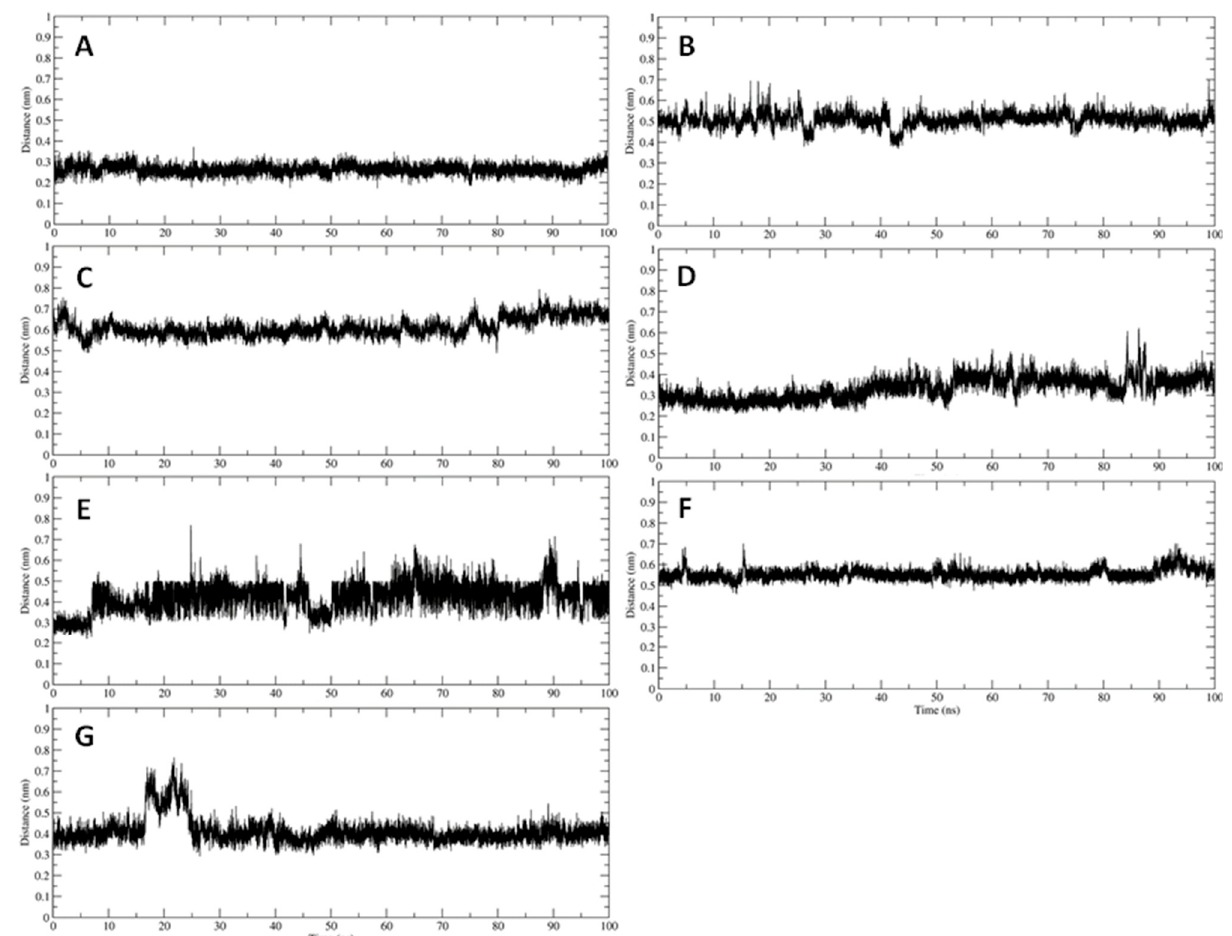
Figure 4. Distance as a function of simulation time between the active site of the protease and the compounds identified through docking experiments. ( A ) Complex between the protease and vitexin. ( B ) Complex between the protease and pentagalloyl-glucose. ( C ) Complex between protease and quercetin. ( D ) Complex between protease and magniolioside. ( E ) Complex between protease and isovitexin. ( F ) Complex between the protease and artelin. ( G ) Complex between the protease and isoorientine. Table 4. Results of MM-GBSA analysis of the 3CLpro- PEL compounds complexes. For each com- pound, we reported the average interaction energy calculated over the last 30 ns of the trajectory.